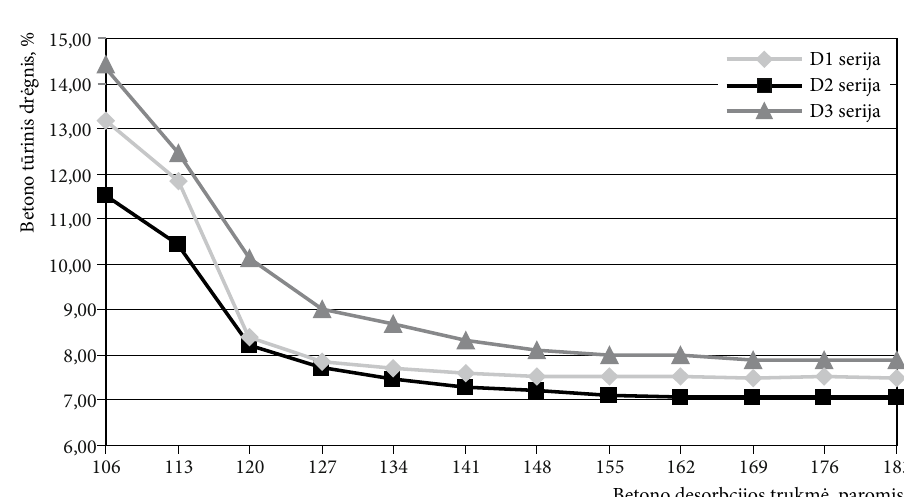
Betono desorbcijos trukmė,